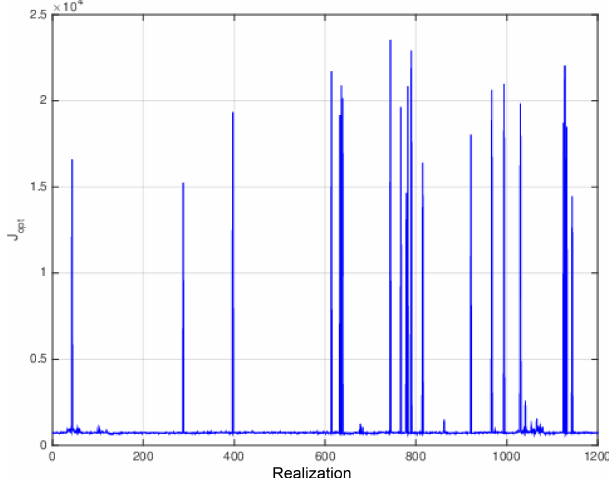
Figure 11. Values of (half) the minima of the objective function for all realizations of the weak-constraint assimilations over 18-day